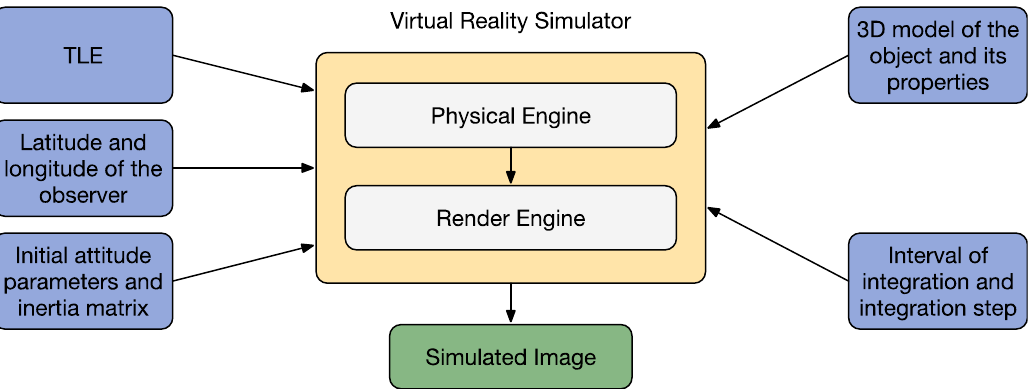
Figure 14. VISONE schematic—some of the input parameters taken by VISONE are: the interval of integration and the time step the 3D model of the object of which we want to find the attitude, its inertia matrix and its initial dynamical state (i.e., initial angle and angular velocity); the last TLE of the object, as well as the position of the observer. VISONE then computes the position of the object and the sun in the same reference frame and renders on an image the 3D model of the orbital object as it should be seen by an observer on Earth.